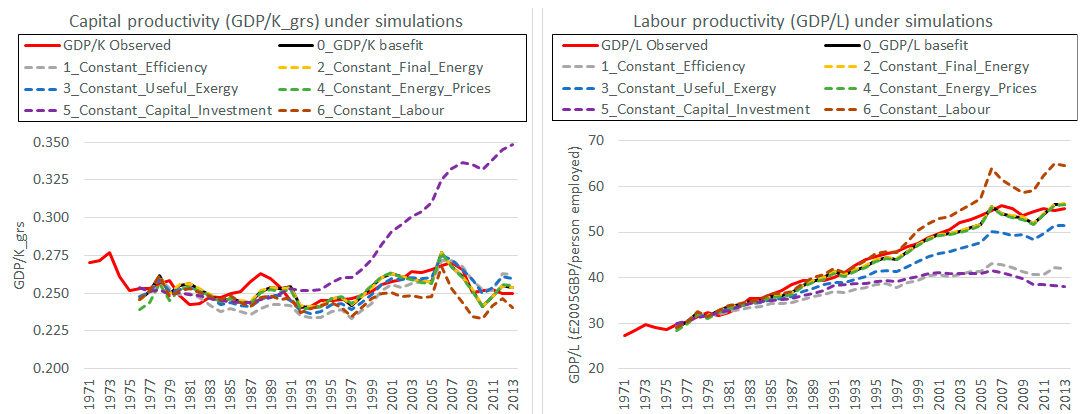
Figure 5. Capital and labour productivity under simulations.